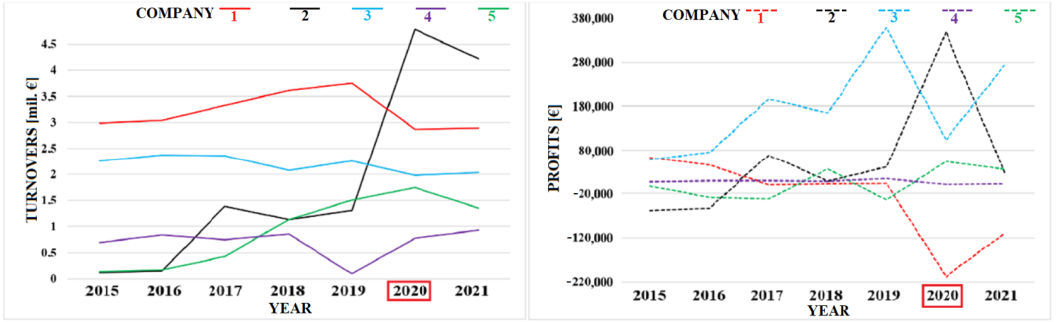
Figure 4. Development of turnovers and profits of wine producers having their profits of EUR 1 to 5 million annually [56].